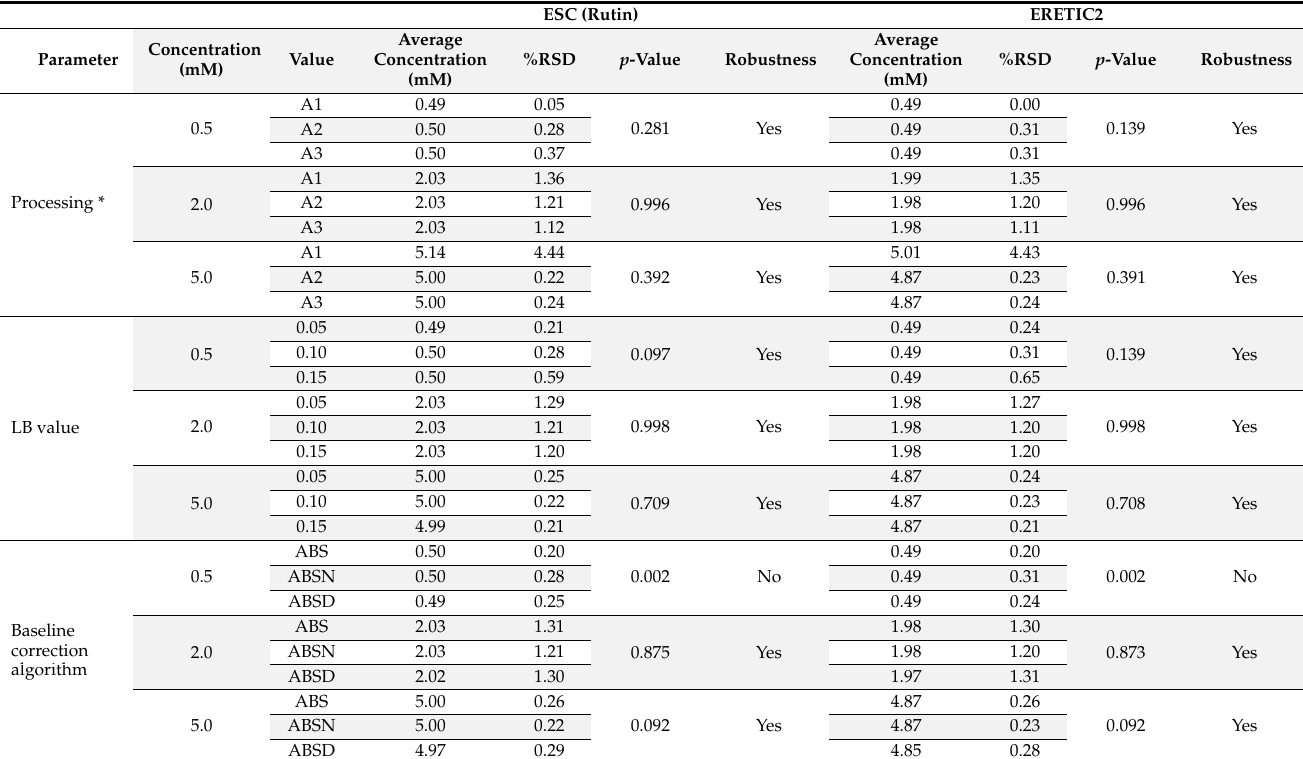
Table 8. Results of robustness evaluation for ESC and ERETIC2 methods. The evaluated parameters were the following: the LB value, processing (by three different analysts) and baseline correction function. A p value < 0.05 was the cutoff to establish significant